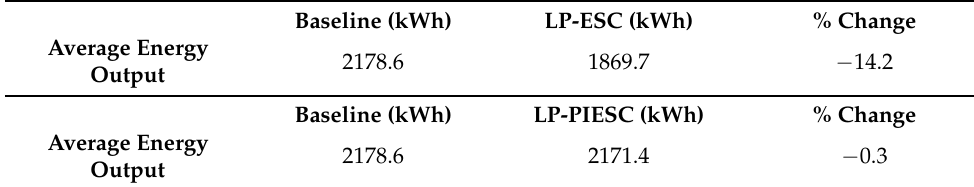
Table 4. Average energy capture for both LP-ESC and LP-PIESC compared to baseline.